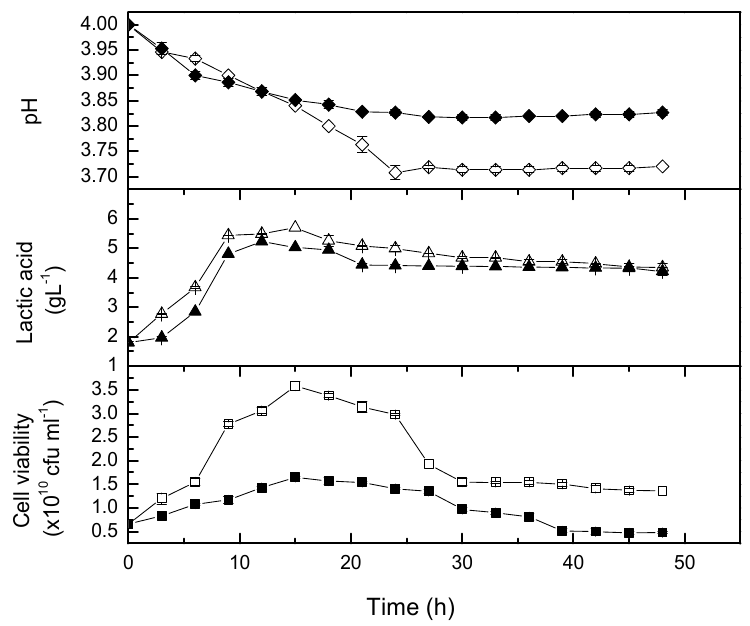
Figure 5. Time course of cell viability and lactic acid concentration, as well as pH changes during probiotication for 48 hours. The open symbol is growth kinetic at 0 rpm, and the closed symbol is growth kinetic at 50 rpm. 163